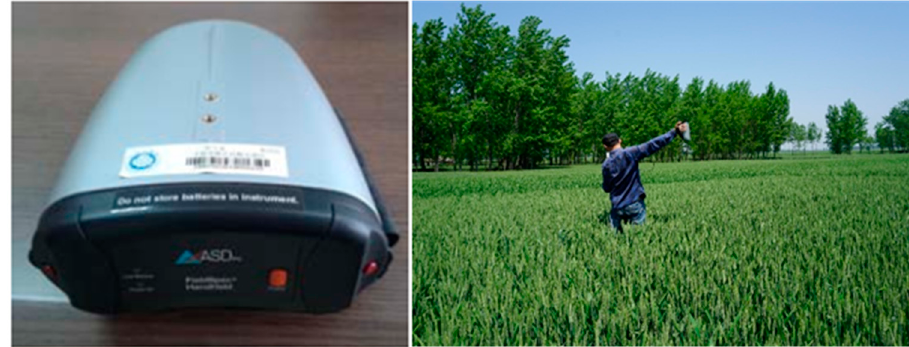
Figure 2. ASD FieldSpec HandHeld spectrometer (left) field data measured scene.(right)